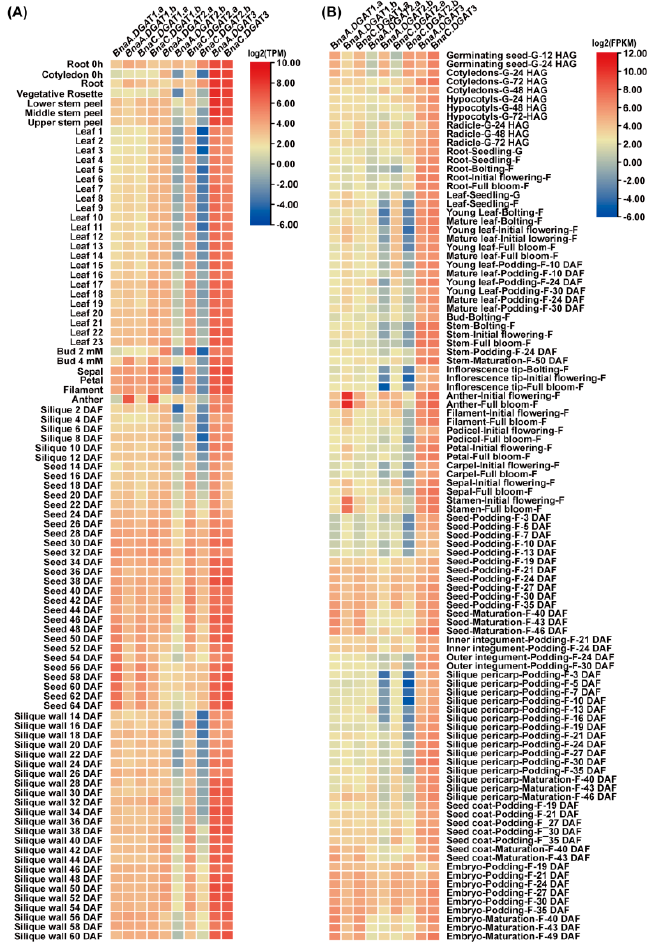
Figure 6. Transcriptomic analysis of BnaDGATs in different tissues. ( A ) The analysis based on BnTIR; ( B ) The analysis based on BrassicaEDB. RNA-Seq datasets of different tissues at diverse stages